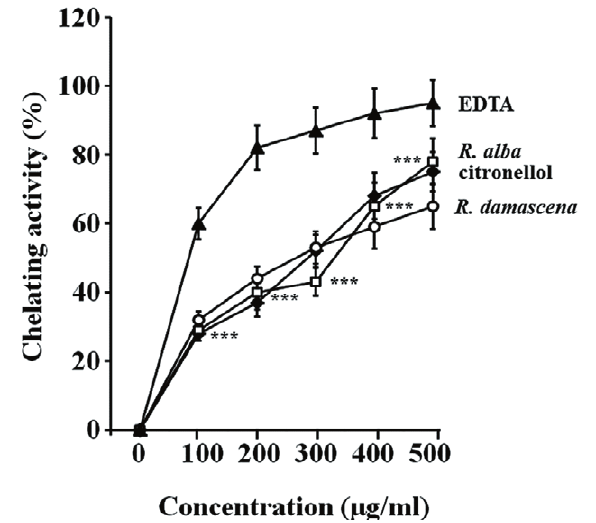
Figure 3. Chelating activity of Bulgarian Rosa alba L. essential oil and its main constituent citronellol. The essential oil from Rosa damascena Mill. was used as a control. Data are expressed as mean ± SD of three independent experiments. ***p<0.001 compared with EDTA.